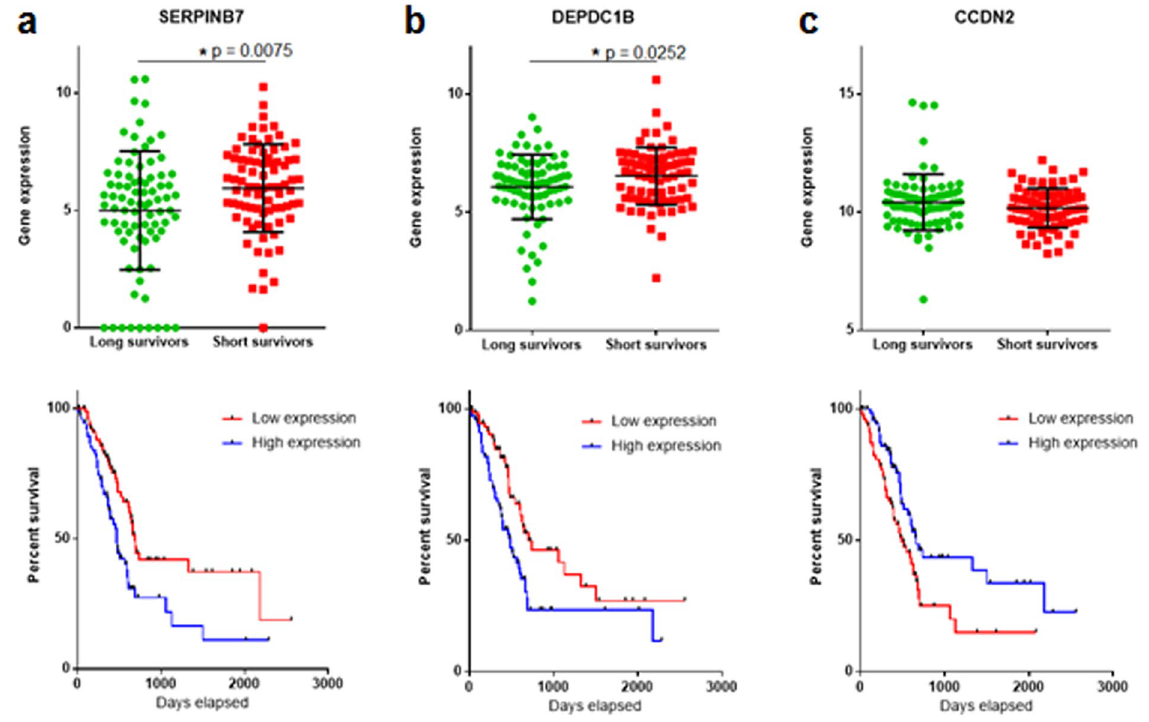
Figure 2. Validation of genes differentially expressed in the short and long survivor groups. Gene expression level of SERPINB7 ( A ), DEPDC1B ( B ) and CCDN2 ( C ) in the short and long survivor groups. P values were calculated using the unpaired t-test. At the bottom, Kaplan-Meier curves for OS based on the expression level of SERPINB7 ( A ), DEPDC1B ( B ) and CCDN2 ( C